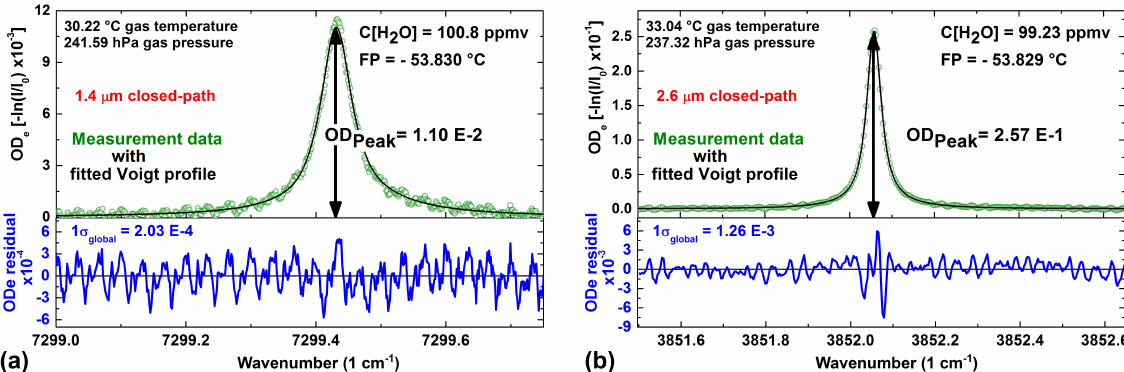
Figure 7. Typical pre-processed absorption signals (after baseline, offset, and transmission correction) for both closed-path spectrometer channels (left: 1.4µm; right: 2.6µm) during flight. The laser modulation frequency was 240Hz. Fifty individual raw scans are pre-averaged yielding 4.8 H 2 O measurements per second with 69ms total integration time. This corresponds to a spatial resolution of 15m at 800kmh − 1 cruising speed. Without averaging, HAI achieves a maximum time resolution of 1.3ms at a spatial resolution of 30cm at 800kmh − 1 cruising speed. (It should be noted that the four vertical axes have different